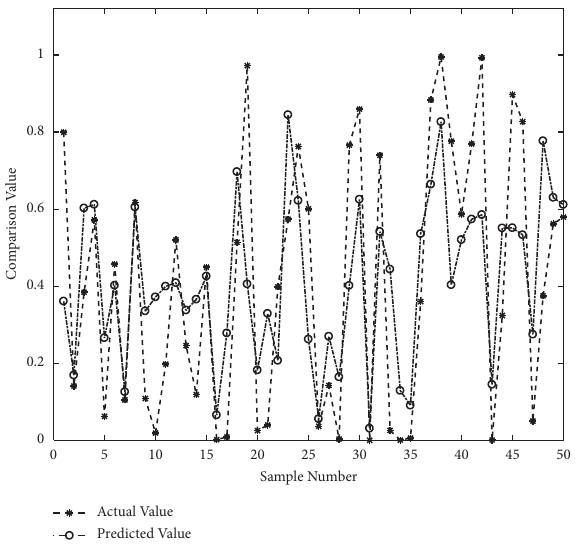
Figure 7: DNN prediction.